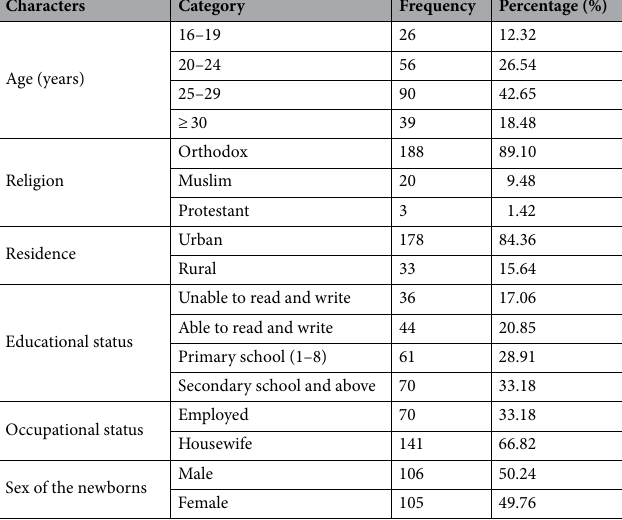
Table 1. Sociodemographic characteristics of the study participant of the pregnant mother and the newborns Northwest Ethiopia, 2019 (n = 211).